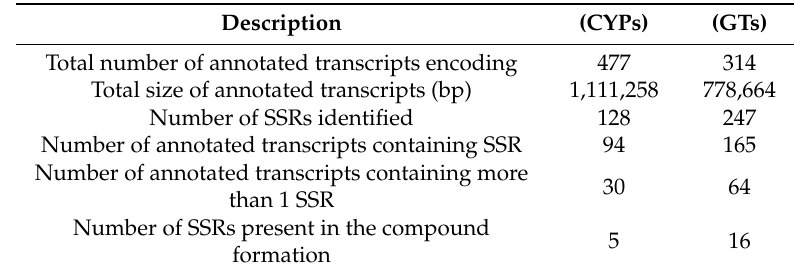
Table 4. Prediction of simple sequence repeats (SSRs) for the annotated transcripts with cytochrome p450s (CYPs) and glucosyltransferase (GTs).